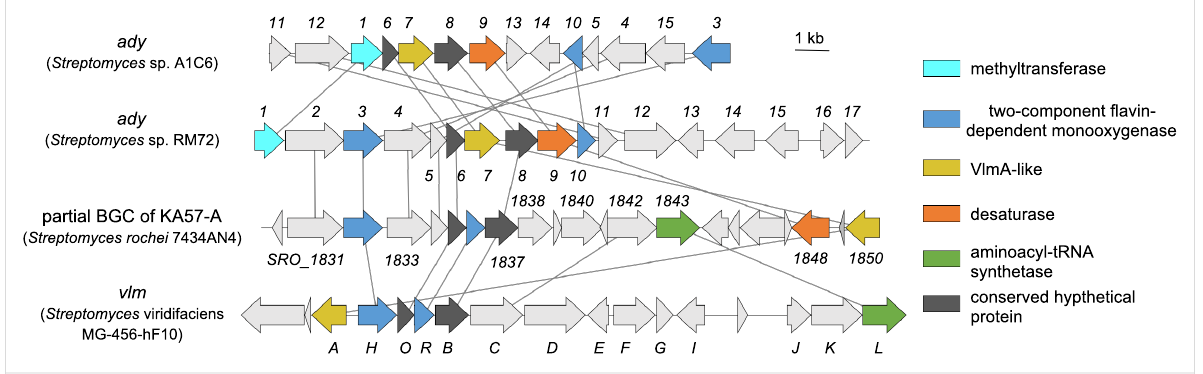
Figure 2: Biosynthetic gene clusters of aliphatic azoxy natural products. Conserved proteins are colored according to their functional annotations. Genes encoding homologous proteins with more than 30% amino acid sequence identities are linked.